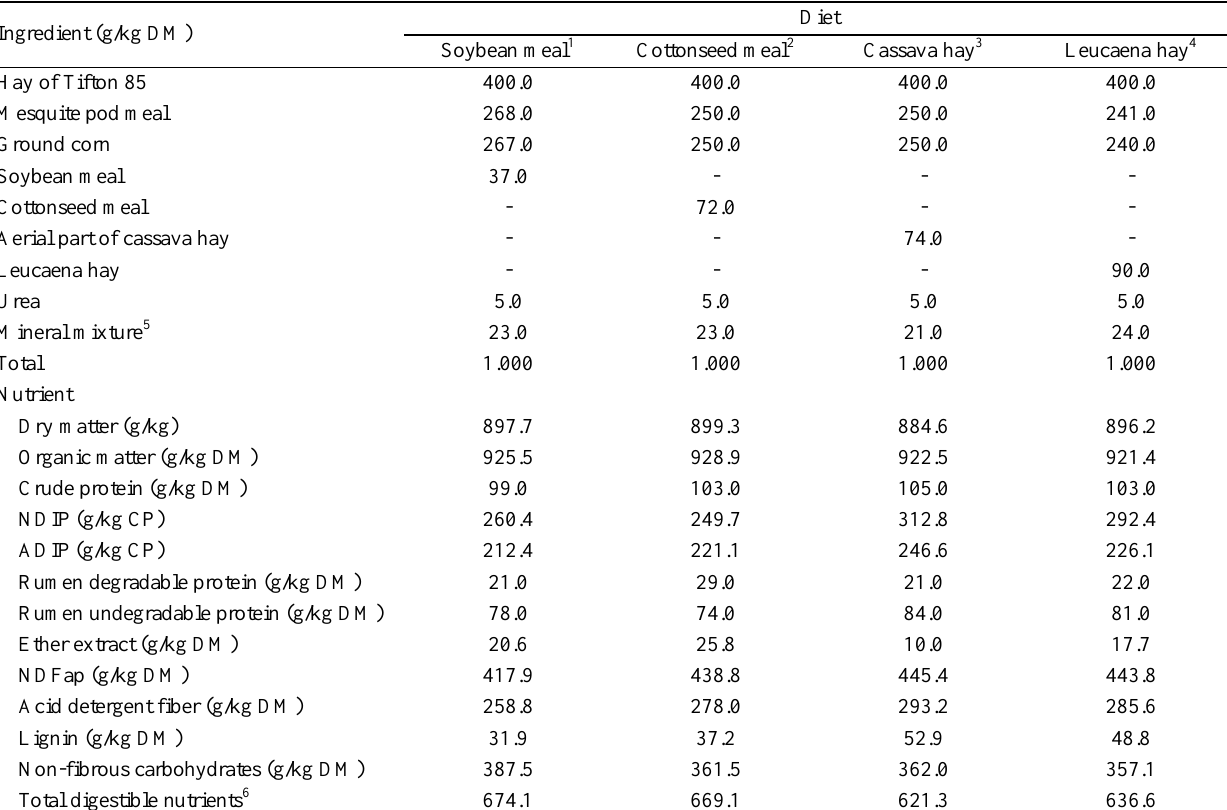
Table 1. Feed composition and nutrient content of experimental